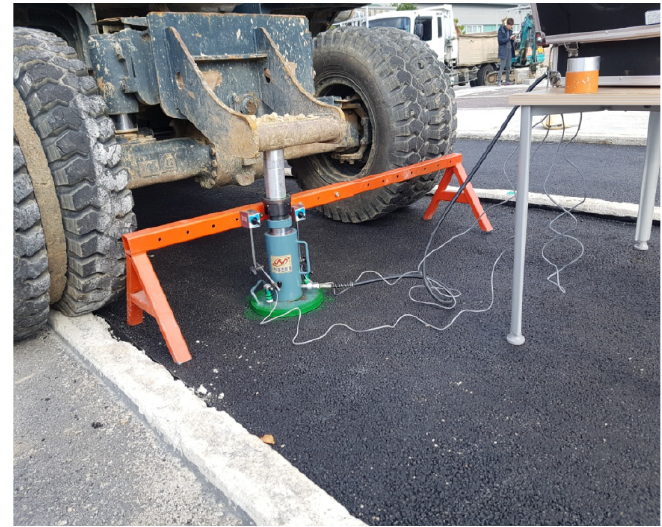
Figure 7. PLT setup for the pavements.